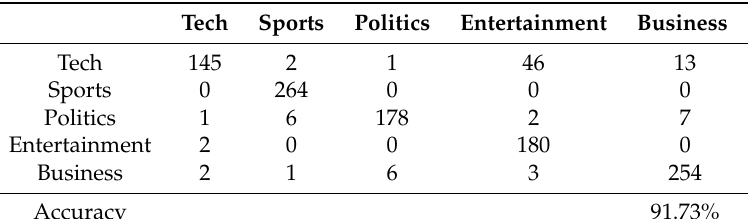
Table 2. Output of the simple LSTM on the English dataset.